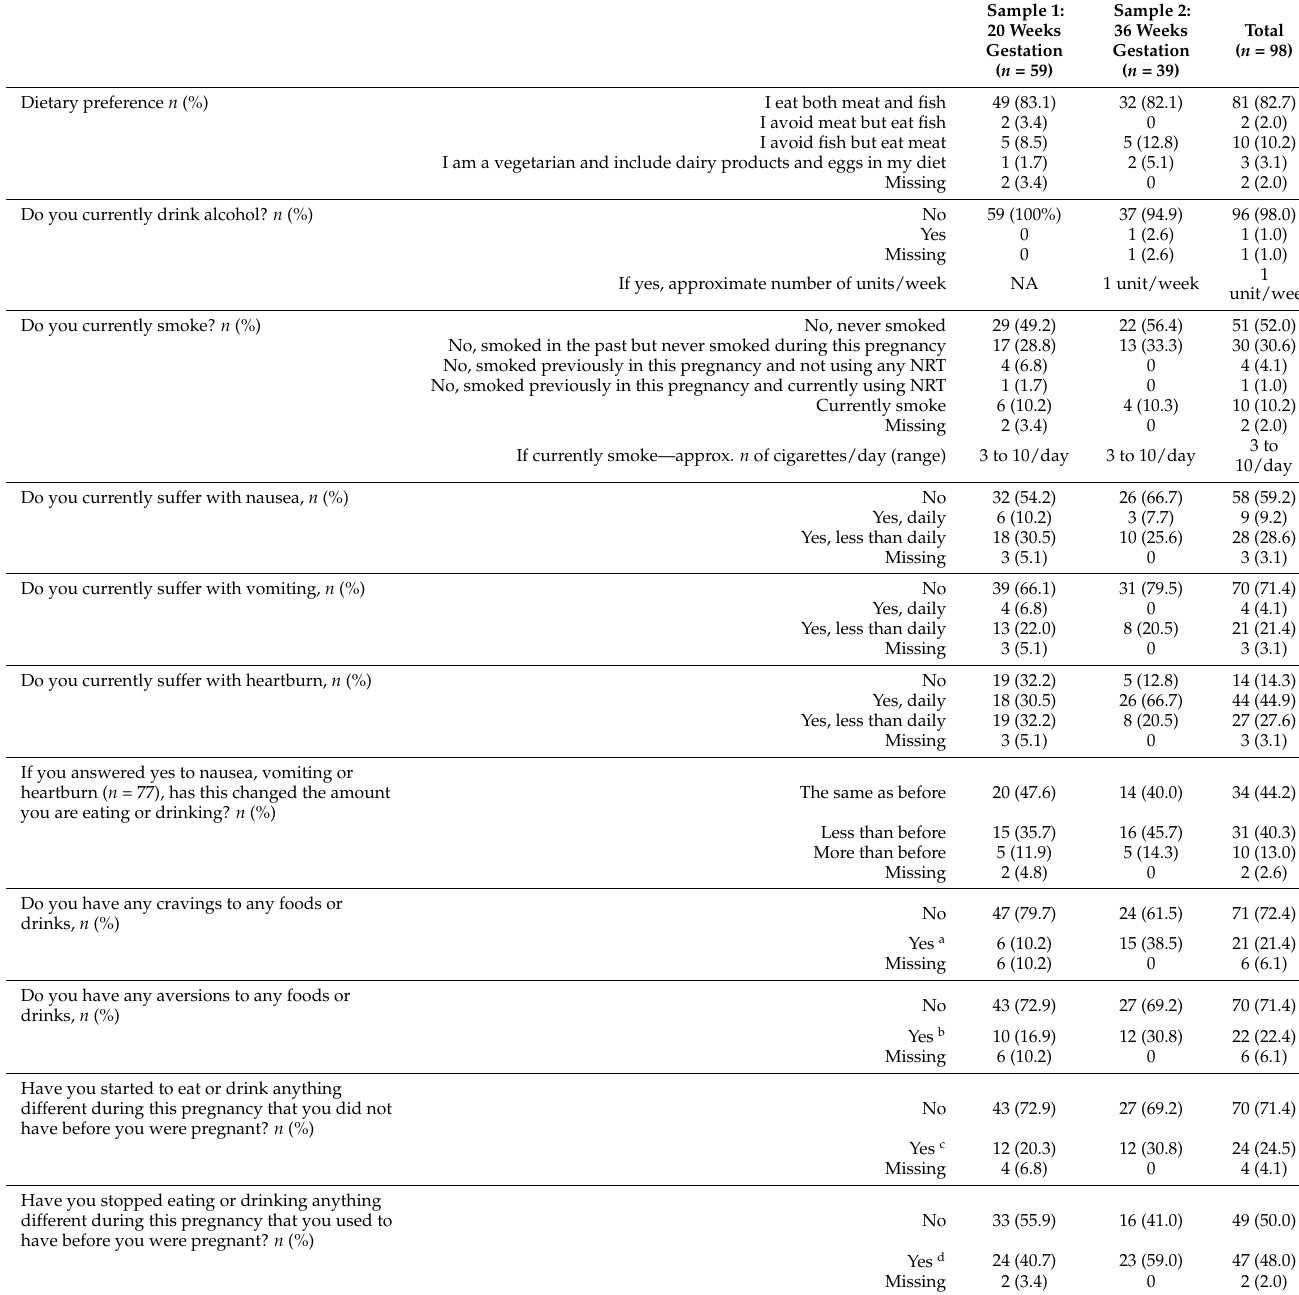
Table 2. Descriptive characteristics of the population for variables related to dietary